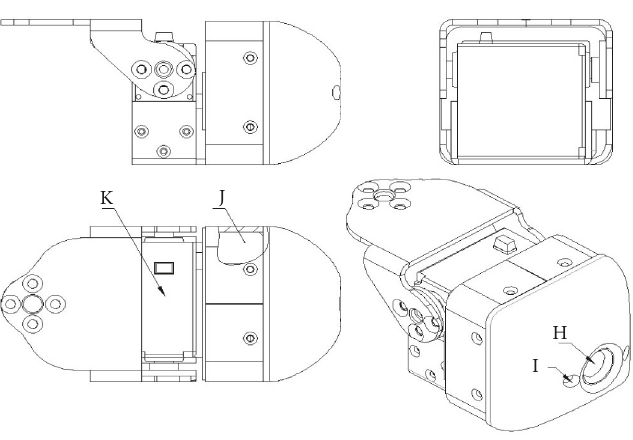
Figure 4: Design diagram of the snake head joint.